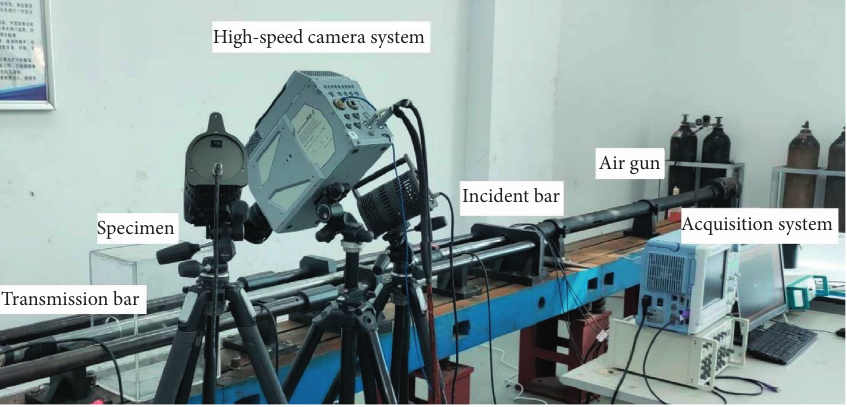
Figure 1: SHPB test system.